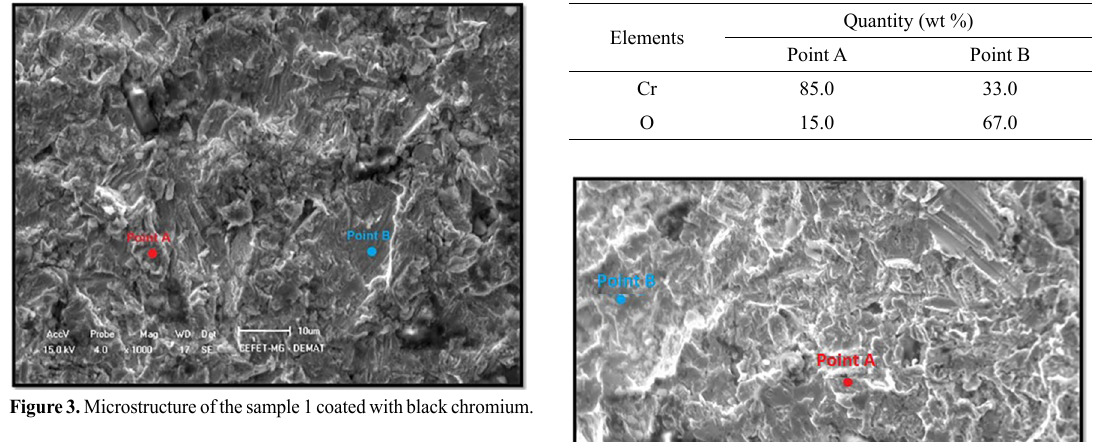
Table 4. Chemical compositon of the sample 1 in differents points.